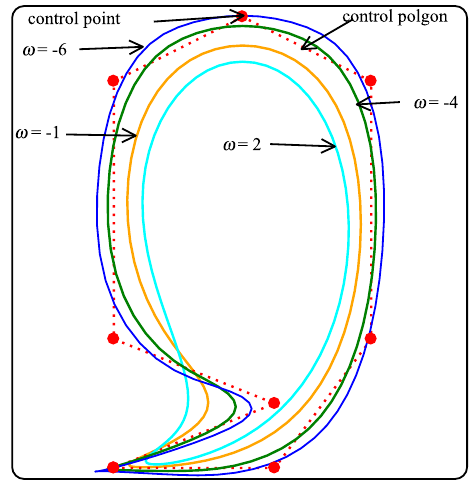
Figure 6. Parameter effect on the limit curves with initial polygon of quaternary scheme.